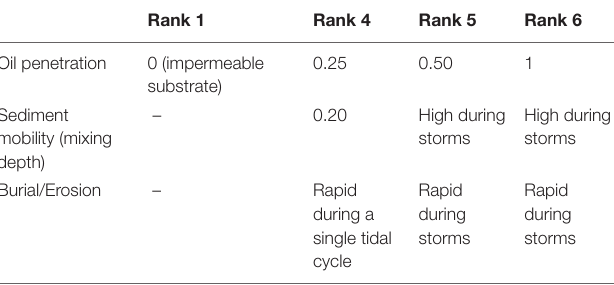
TABLE 5 | Vertical extents of oil penetration, sediment mobility, and burial (or erosion) of the different vulnerability levels according to ESI guidelines by National Oceanic and Atmospheric Administration [NOAA]